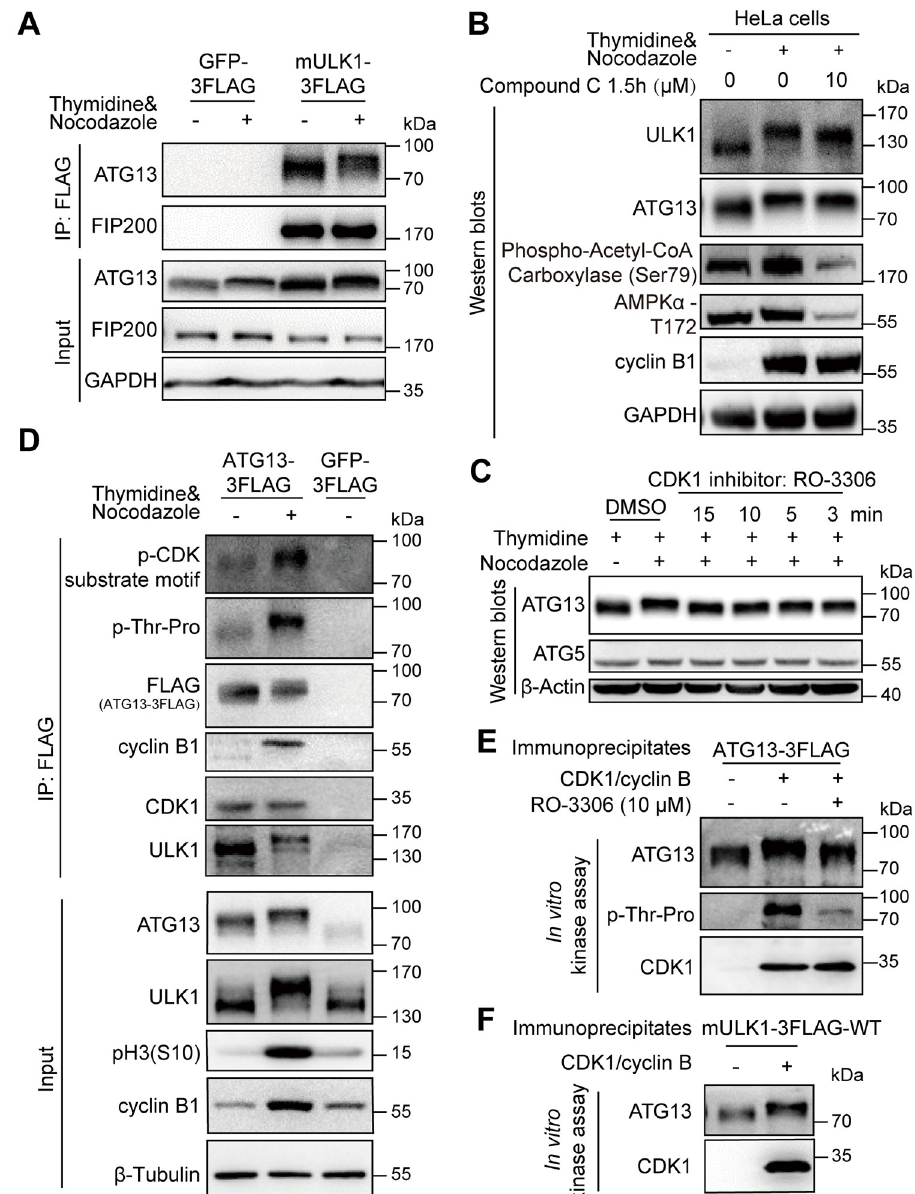
Fig 4. ATG13 is a substrate of CDK1/cyclin B in mitosis. (A) Mitotic ATG13 undergoes mobility upshift in mitosis in electrophoresis. The 293T cells overexpressing FLAG-tagged mULK1 or GFP were synchronized by single- thymidine in the presence or absence of nocodazole and coimmunoprecipitated by the FLAG antibody followed by western blot analysis. Size of endogenous ATG and expressed FLAG-tagged ATG13 were not distinguishable in electrophoresis here. (B) The effect of AMPK inhibition on ULK1 and ATG13 mobility shift in mitosis. The AMPK inhibitor Compound C was used to evaluate the role of AMPK on ULK1 or ATG13 mobility shift as Fig 3B. Phospho- AMPK α -T172 and phospho-Acetyl-CoA Carboxylase (Ser79) were used to indicate AMPK inhibition. (C) CDK1 inhibitor RO-3306 decreases the ATG13 band shift in mitosis. HeLa cells synchronized and treated as Fig 3A were subjected to western blot analysis. (D) ATG13 is phosphorylated and interacts with CDK1/cyclin B1 in mitosis. The 293T cells overexpressing FLAG-tagged ATG13 were synchronized by single-thymidine in the presence or absence of nocodazole. The coimmunoprecipitates by FLAG antibody were subjected to western blot analysis. (E-F) ATG13 is directly phosphorylated by purified CDK1/cyclin B complex in vitro. The ATG13 immunoprecipitates from asynchronous 293T cells overexpressing FLAG-tagged ATG13 or ULK1 and purified CDK1/cyclin B complex were subjected to in vitro kinase assay with or without RO-3306 followed by western blot analysis. (E) shows representative western blot analysis of the ATG13 immunoprecipitates as substrate, and (F) shows the representative western